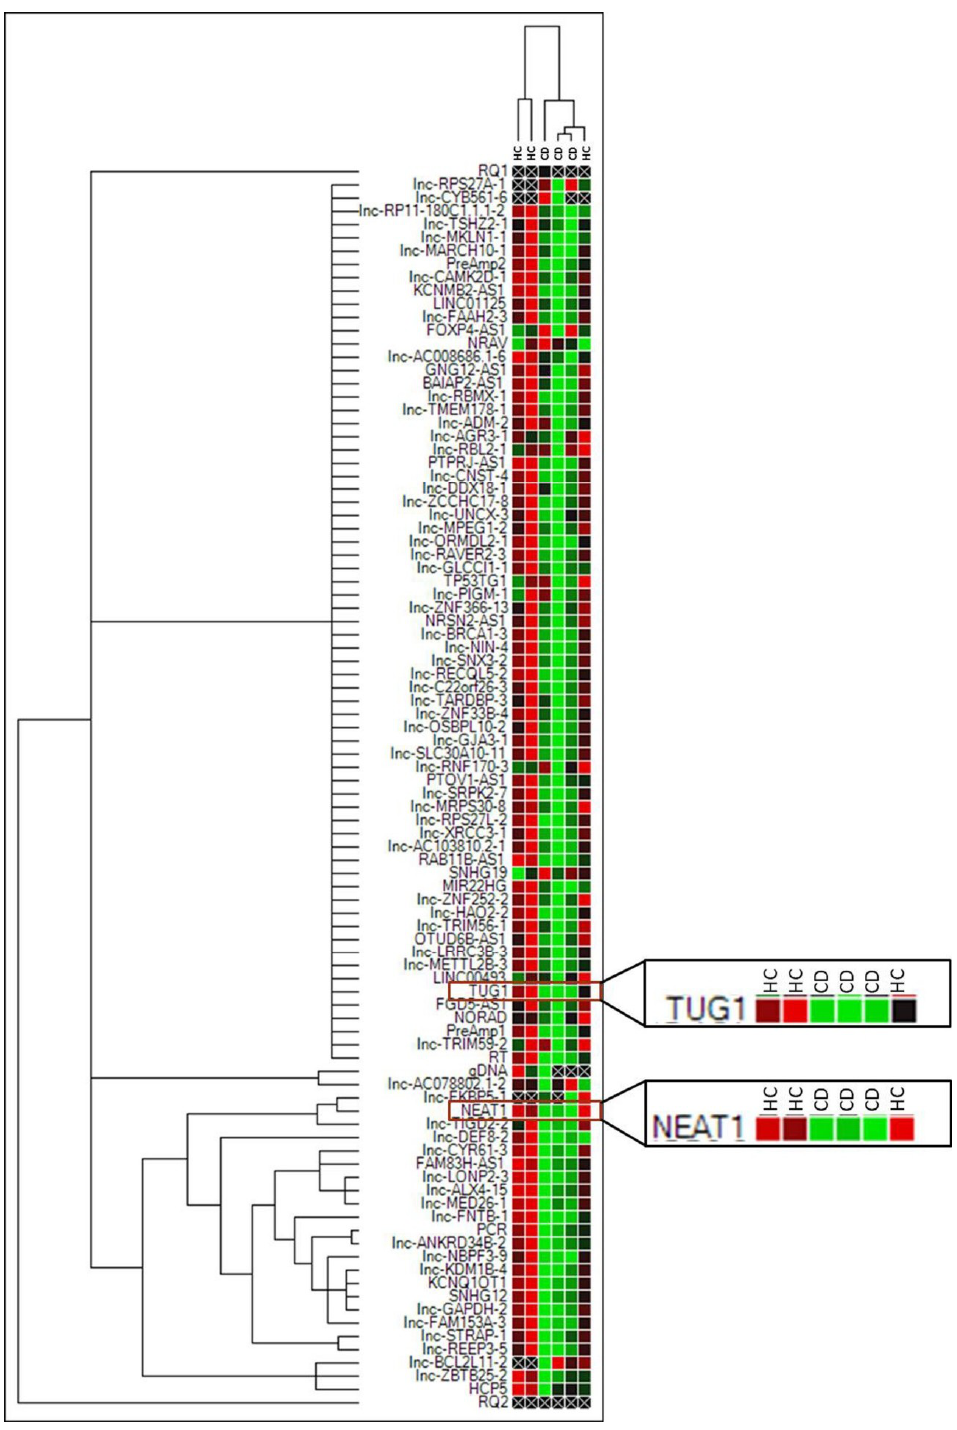
Figure 1. Cluster analysis of the 87 lncRNA array in three Marsh 3C celiac patients (CD) and three healthy controls (HCs). Green = lower expression. Red = higher expression. PreAmp1, PreAmp2, gDNA, PCR, RQ1, RQ2, RT are internal reaction controls.